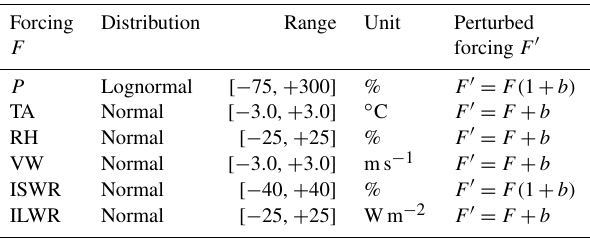
Table 1. Input uncertainties introduced as bias ( b ) to meteorological